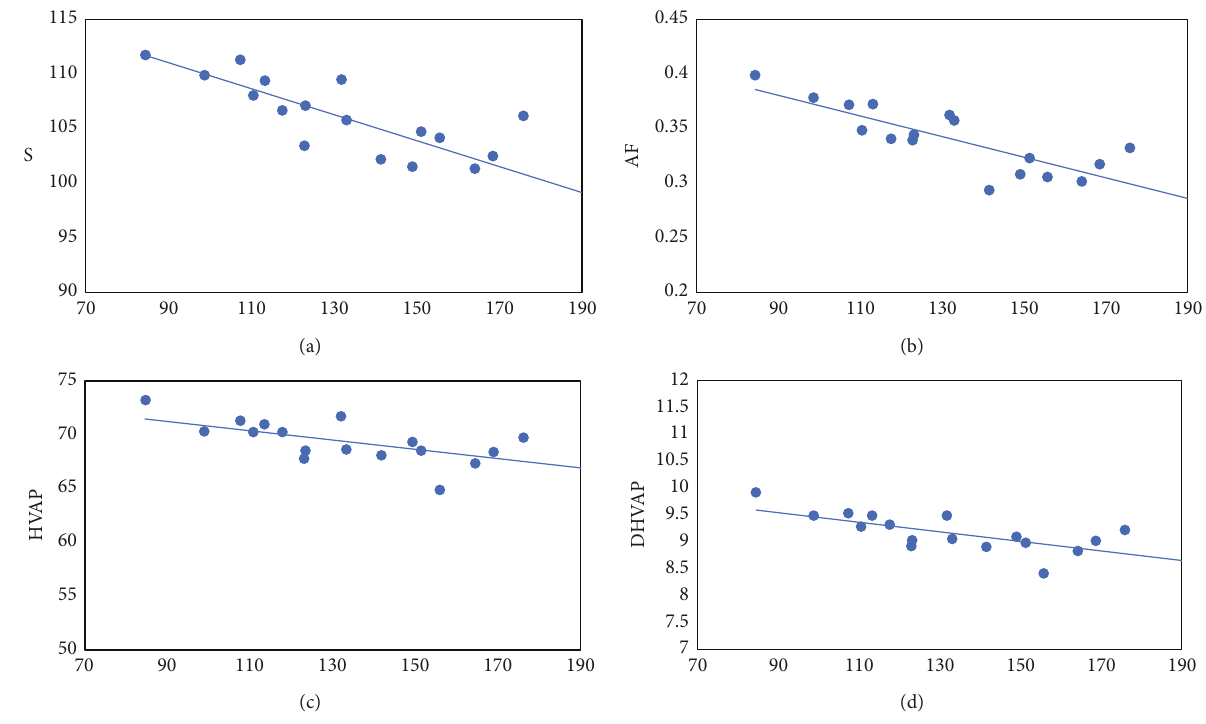
Figure 4: Correlation of NGH ( x -axis) and physical properties S, AF, HVAP, and DHVAP ( y -axis).